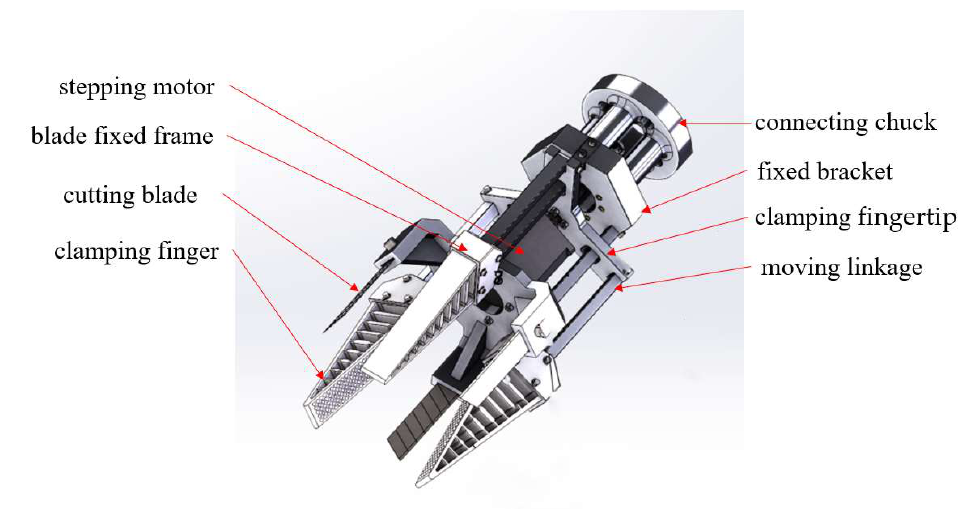
Figure 1. Structure diagram of the end-effector.